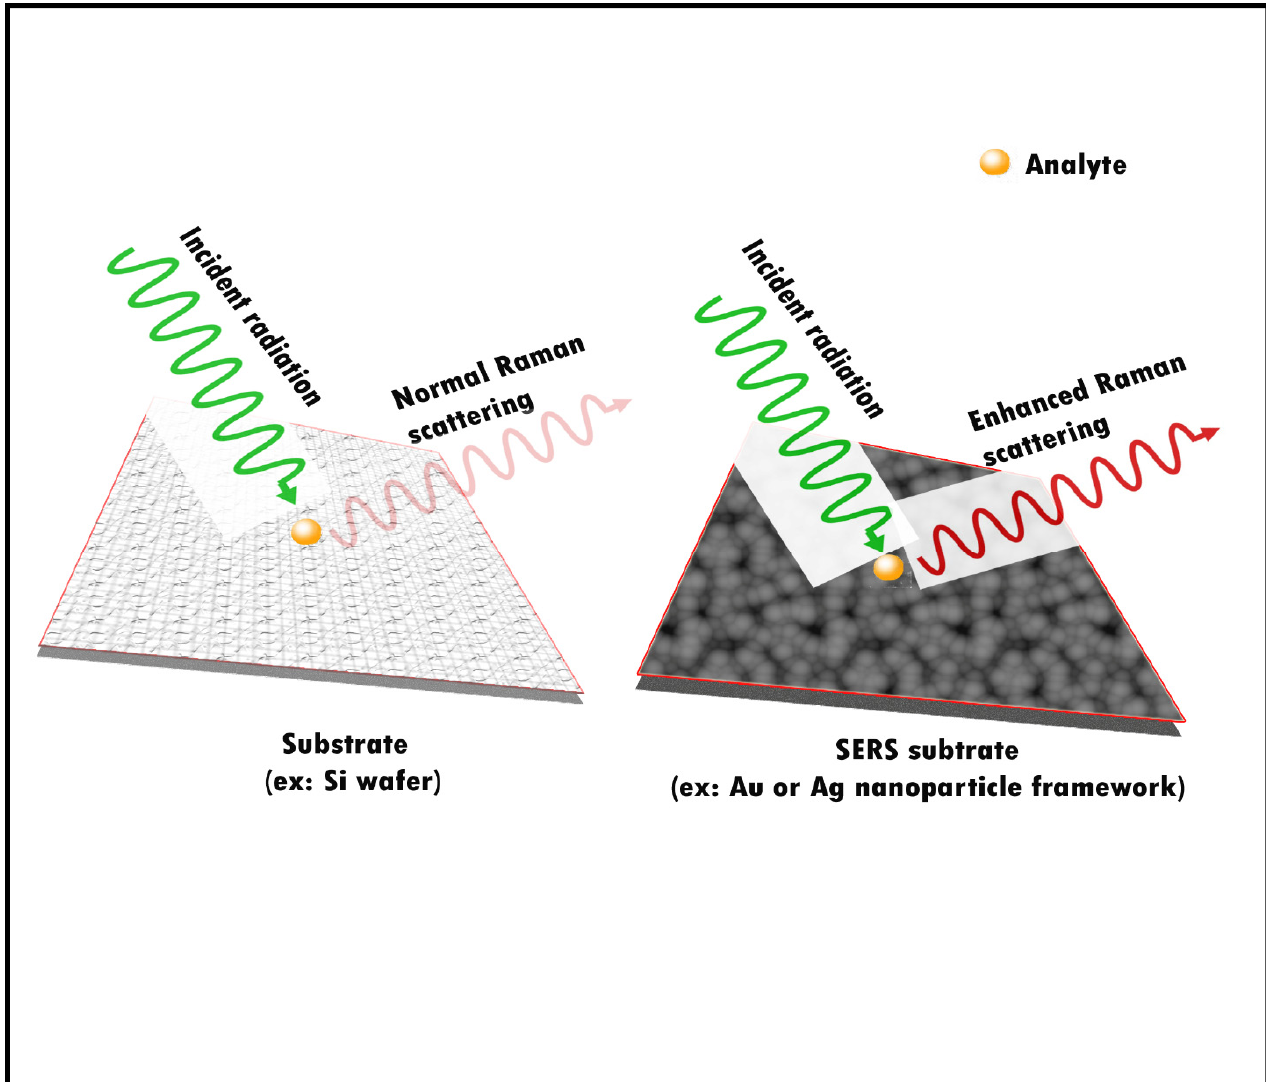
Figure 5. Schematic representation of surface-enhanced Raman spectroscopy (SERS). Silver (Ag) or gold (Au) nanoparticle-coated quartz filters (SERS substrates) are often used for aerosol studies. A Au-coated quartz filter could detect the intraparticle distribu- tion of functional groups ν w (CH 2 )–1022 cm –1 , δ (C–C)–1480 cm –1 , and ν as (NO 3– )–1370 cm – 1 ) over an SOA particle with 0.5 µm spatial resolution [18].